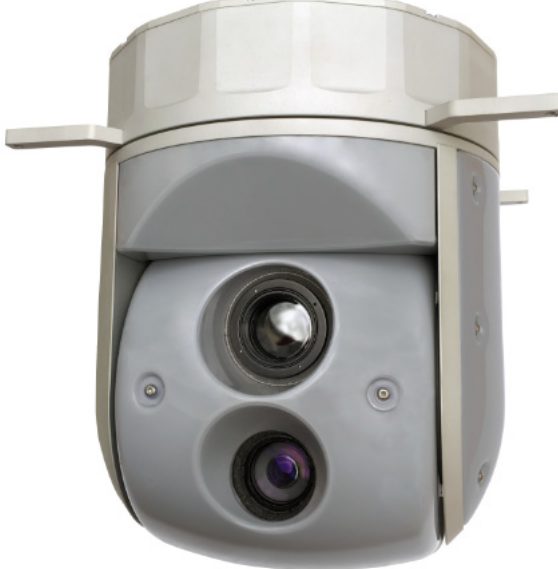
Figure 5. Optoelectronic head developed especially for use with WABIK.